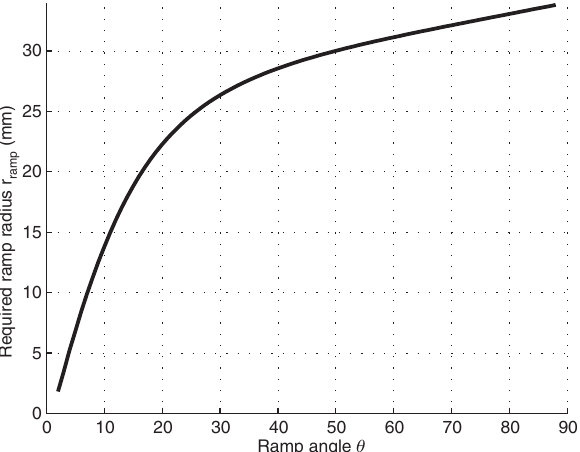
Figure 17 Analytical results for resulting lateral roller slip s for both constant angle and geodesic path planning.